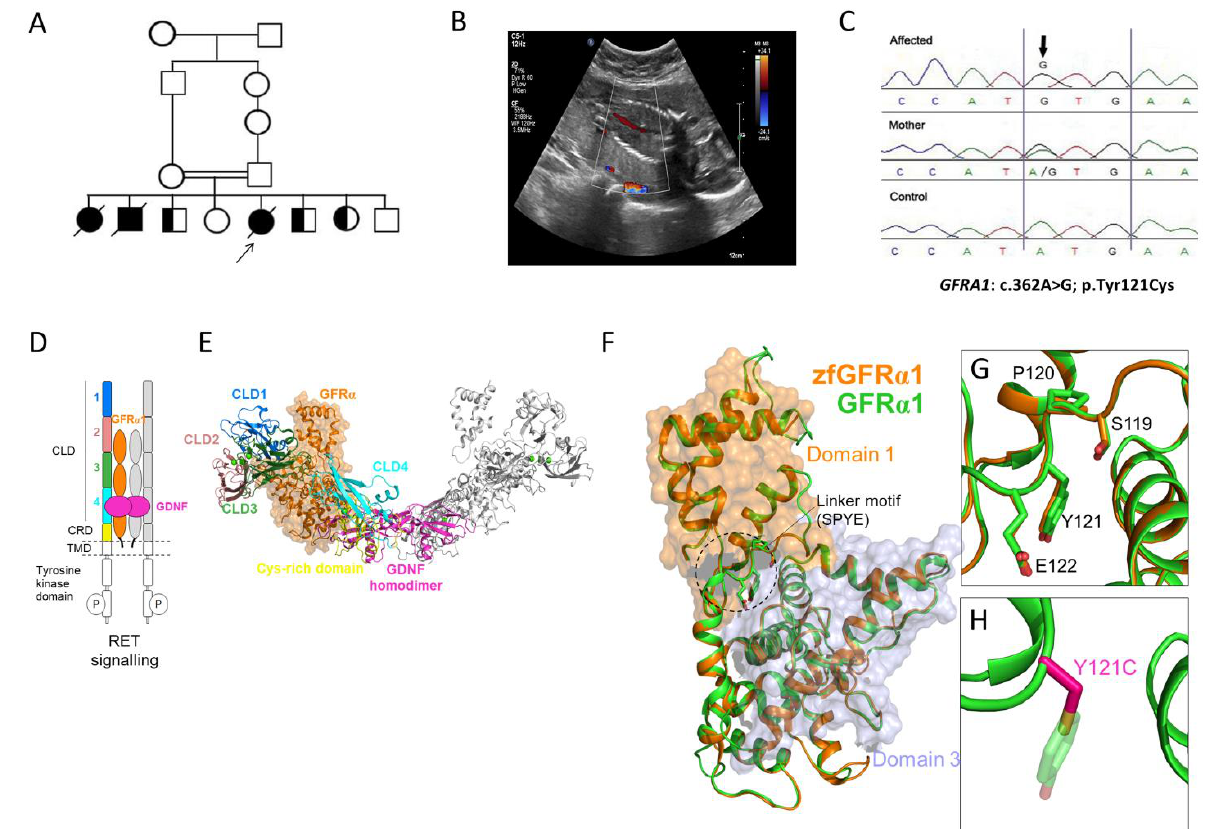
Figure 1. Family 1 with bilateral renal agenesis and GFRA1 variant. ( A ) Pedigree diagram of the studied family with bilateral renal agenesis with the proband arrowed. ( B ) Coronal view of the fetal abdomen at 20 weeks ’ gestation with color Doppler showing the abdominal aorta with no evidence of the left or right renal artery branching, indicating bilateral renal agenesis. ( C ) Sanger sequencing chromatogram of the GFRA1 missense variant (NM_001348098.4: c.362A>G; p.Tyr121Cys) in the affected proband, mother, and control. ( D ) Schematic of the GDNF- GFRα1 -RET signaling system. Receptor tyrosine kinase (RET) dimerization and signaling is activated by association with GDNF (magenta) bound to its GFRα1 co -receptor (orange). For clarity, one-half of the dimerized signaling complex is highlighted: extracellular RET cadherin-like domains (CLD) 1 (blue), 2 (pink), 3 (green), and 4 (cyan) and cysteine-rich domain (CRD) are shown in yellow. ( E ) The cryo-EM structure (col-